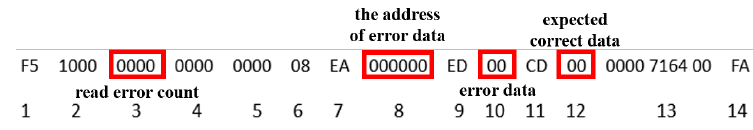
Figure 2. Data description chart on PC software.